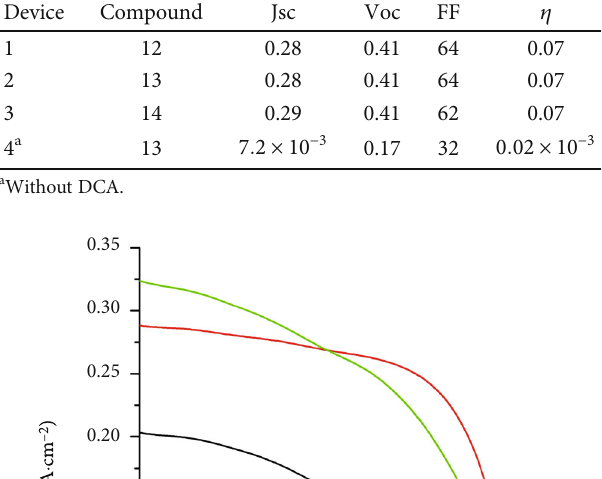
Figure 11: Plot J vs V of devices at di ff erent TiO (black) 5 μ m (1 layer), (red) 12 μ m (2 layers), and (green) 16 μ m (3 layers) prepared by methodology #5.